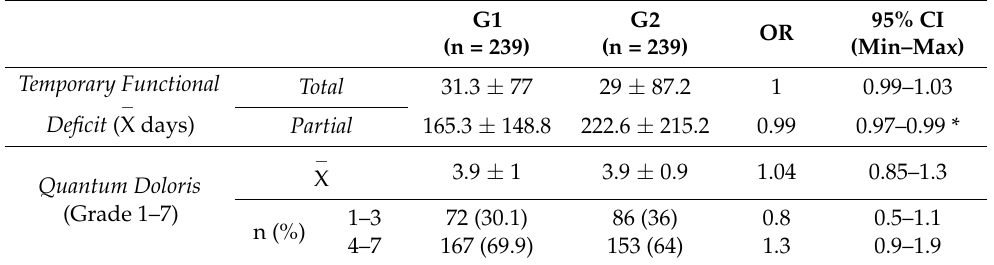
Table 2. Temporary outcomes (medico-legal damage parameters).